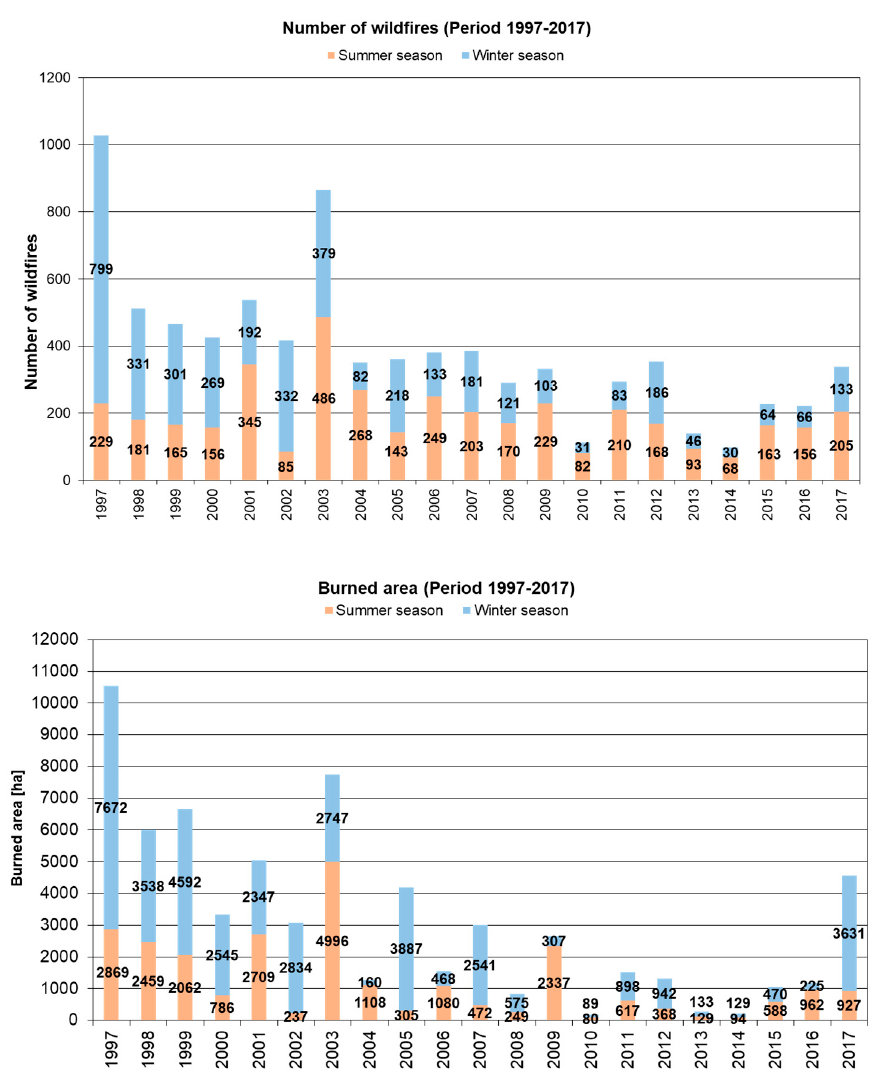
Figure 2. Yearly frequency of wildfires (on the top) and burned area (on the bottom) in the Liguria region (Italy) in the last two decades (1997–2017) during the summer and the winter season.